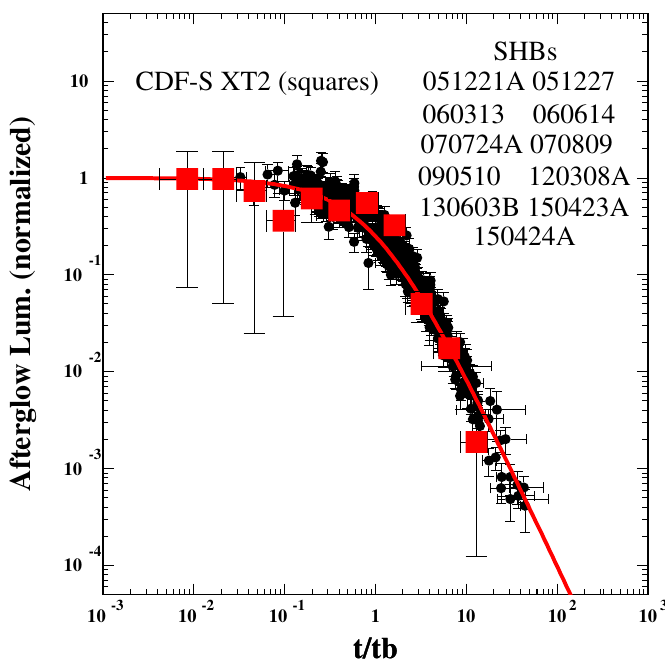
Figure 31. Comparison between the scaled 0.3-10 keV light curves of the well sampled X-ray AGs of SGRBs during the first couple of days after burst measured with the Swift XRT and the 0.3 to 10 keV light curve of CDF-S XT2 [182]. The line is the universal behavior of Equation (19) for a PWN AG powered by a newly-born millisecond pulsar with a braking index n =